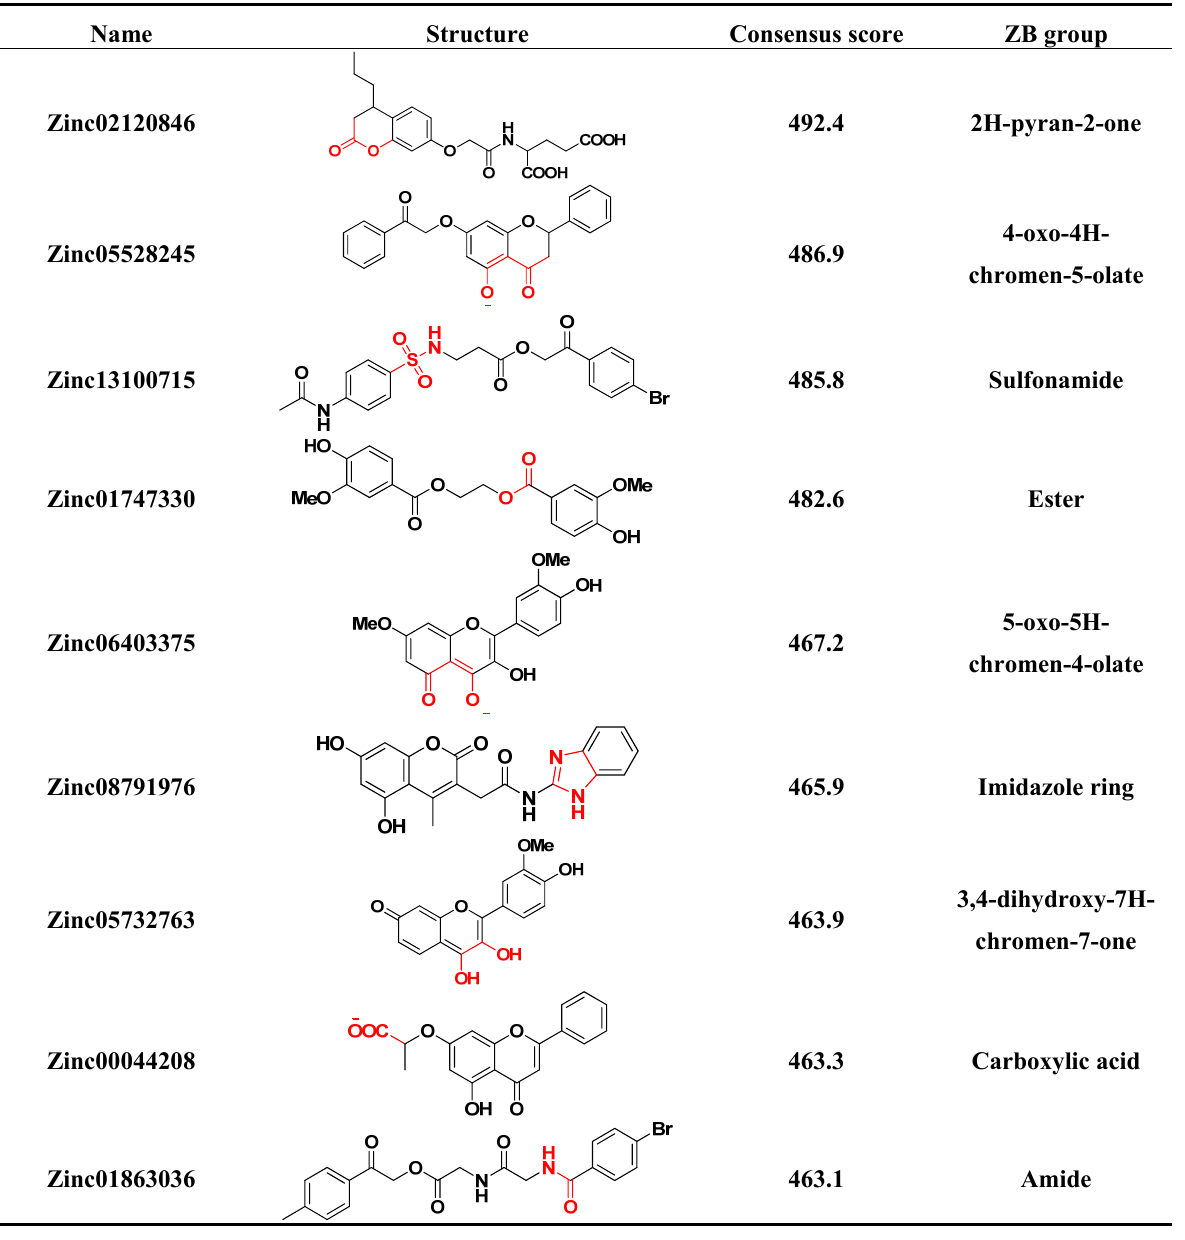
Table 2. Structure, consensus scoring and zinc binding groups of candidate compounds as Glo-1